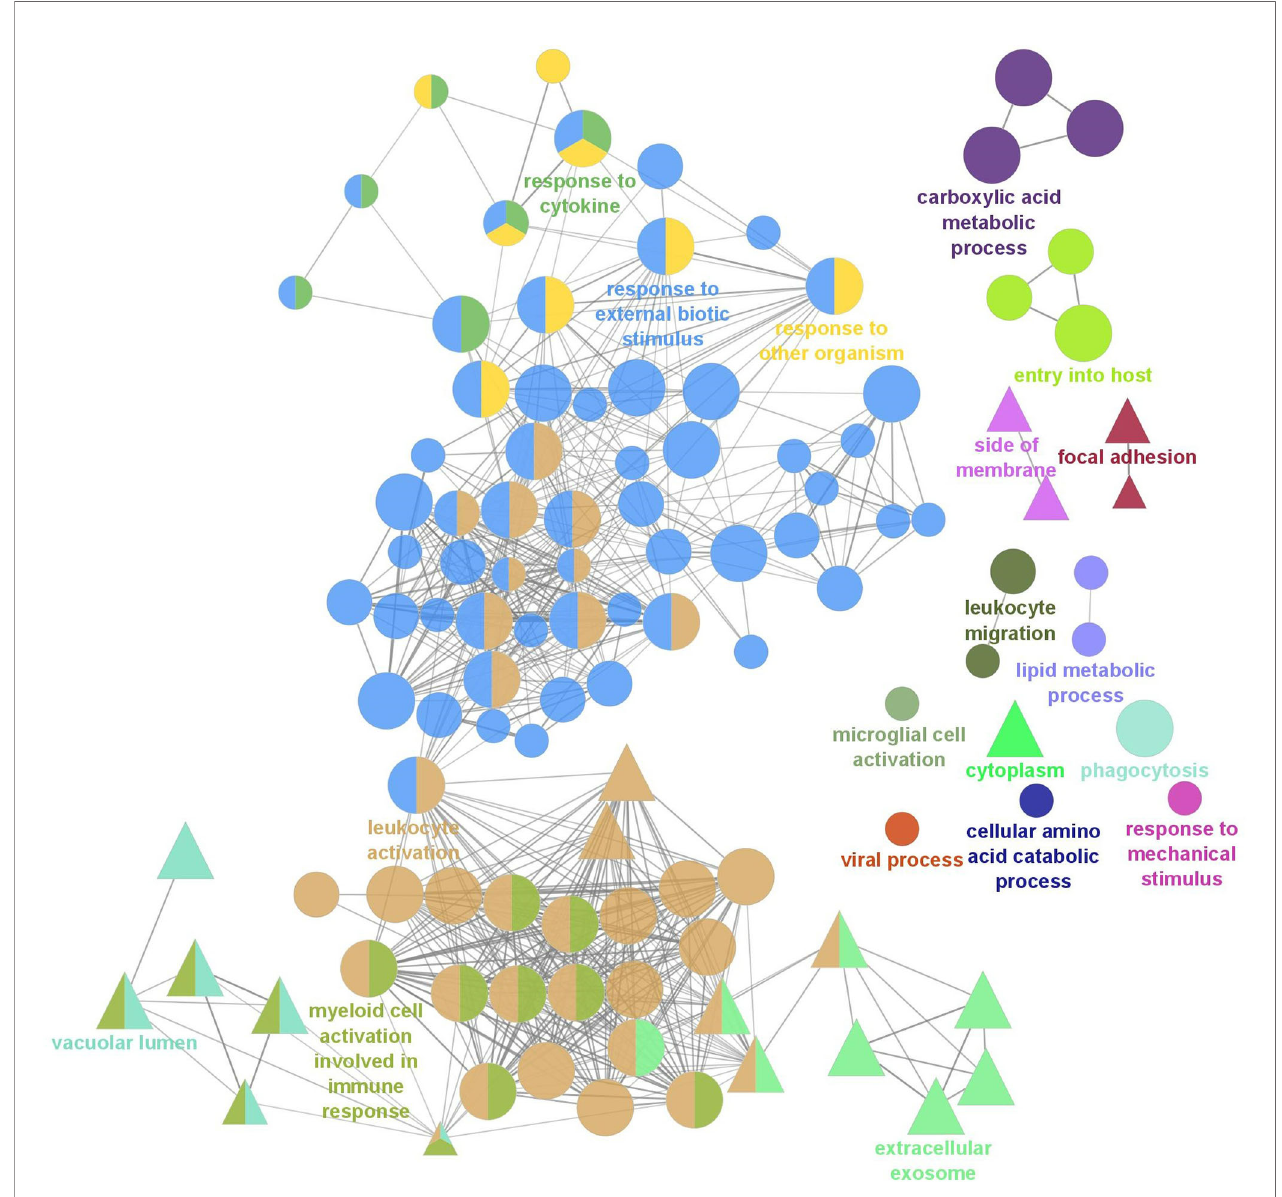
FIGURE 3 | Gene Ontology (GO) term enrichment and network analysis of all DEGs between Day 1 and Day 5 HKLs. Two GO databases were used, Biological Process (BP; represented by circles) and Cellular Component (CC; represented by triangles) and each node represents a signi fi cantly enriched GO term (p<0.05, corrected with the Bonferroni step-down procedure). Related GO terms are labelled with the same colour and, when a term is shared by two or more GO cluster groups, the node is illustrated by multiple colours. The most signi fi cant terms unique to BP and CC are labelled. The size of the node represents the enrichment signi fi cance of the terms, and the thickness of edges indicates the kappa